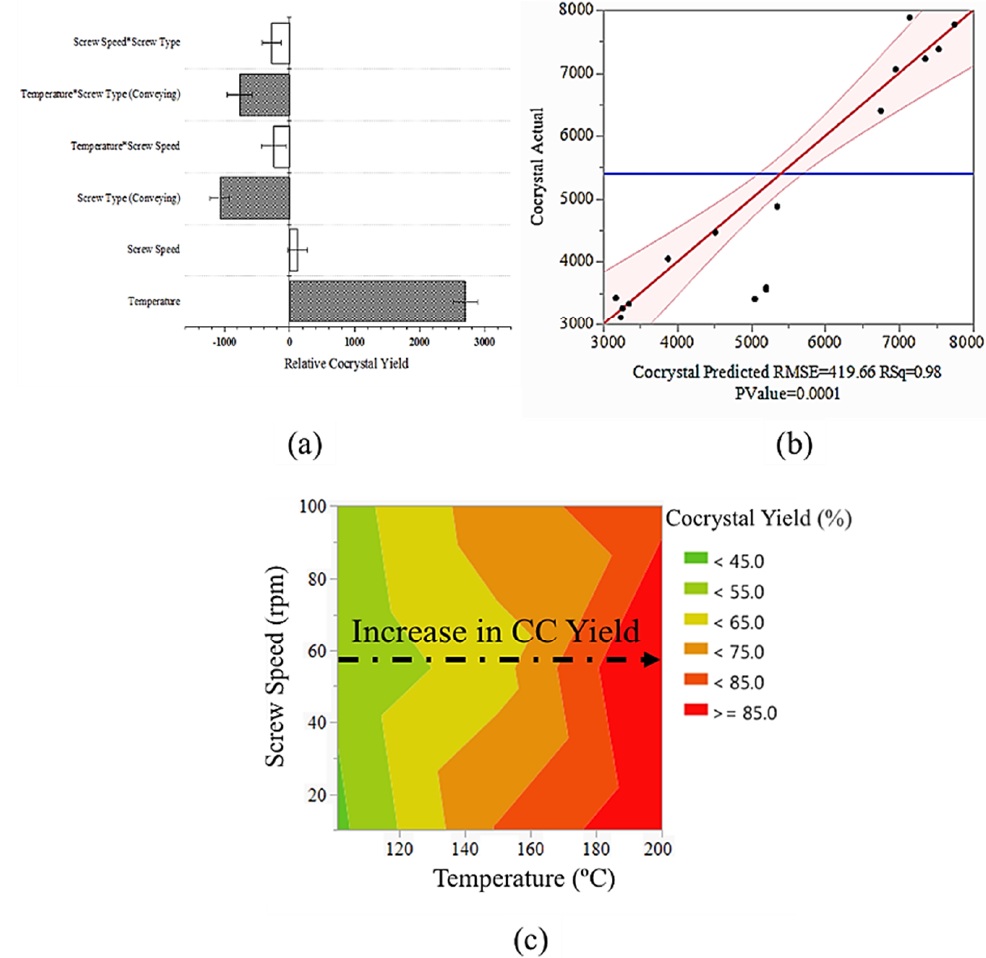
Figure 12. ( a ) Scaled parameter estimates plot with respect to the relative cocrystal yield of hot-melt extrusion process. Intercept estimate = 6276 ± 145. Open bars identify non-significant factors. Shaded bars are the statistically significant factors. Error bars show the estimated standard error for each estimated parameter; ( b ) parity plot shows the goodness of the fit with R 2 = 0.98; ( c ) contour plot of the effect of screw speed and temperature on the final cocrystal yield of hot-melt extruded